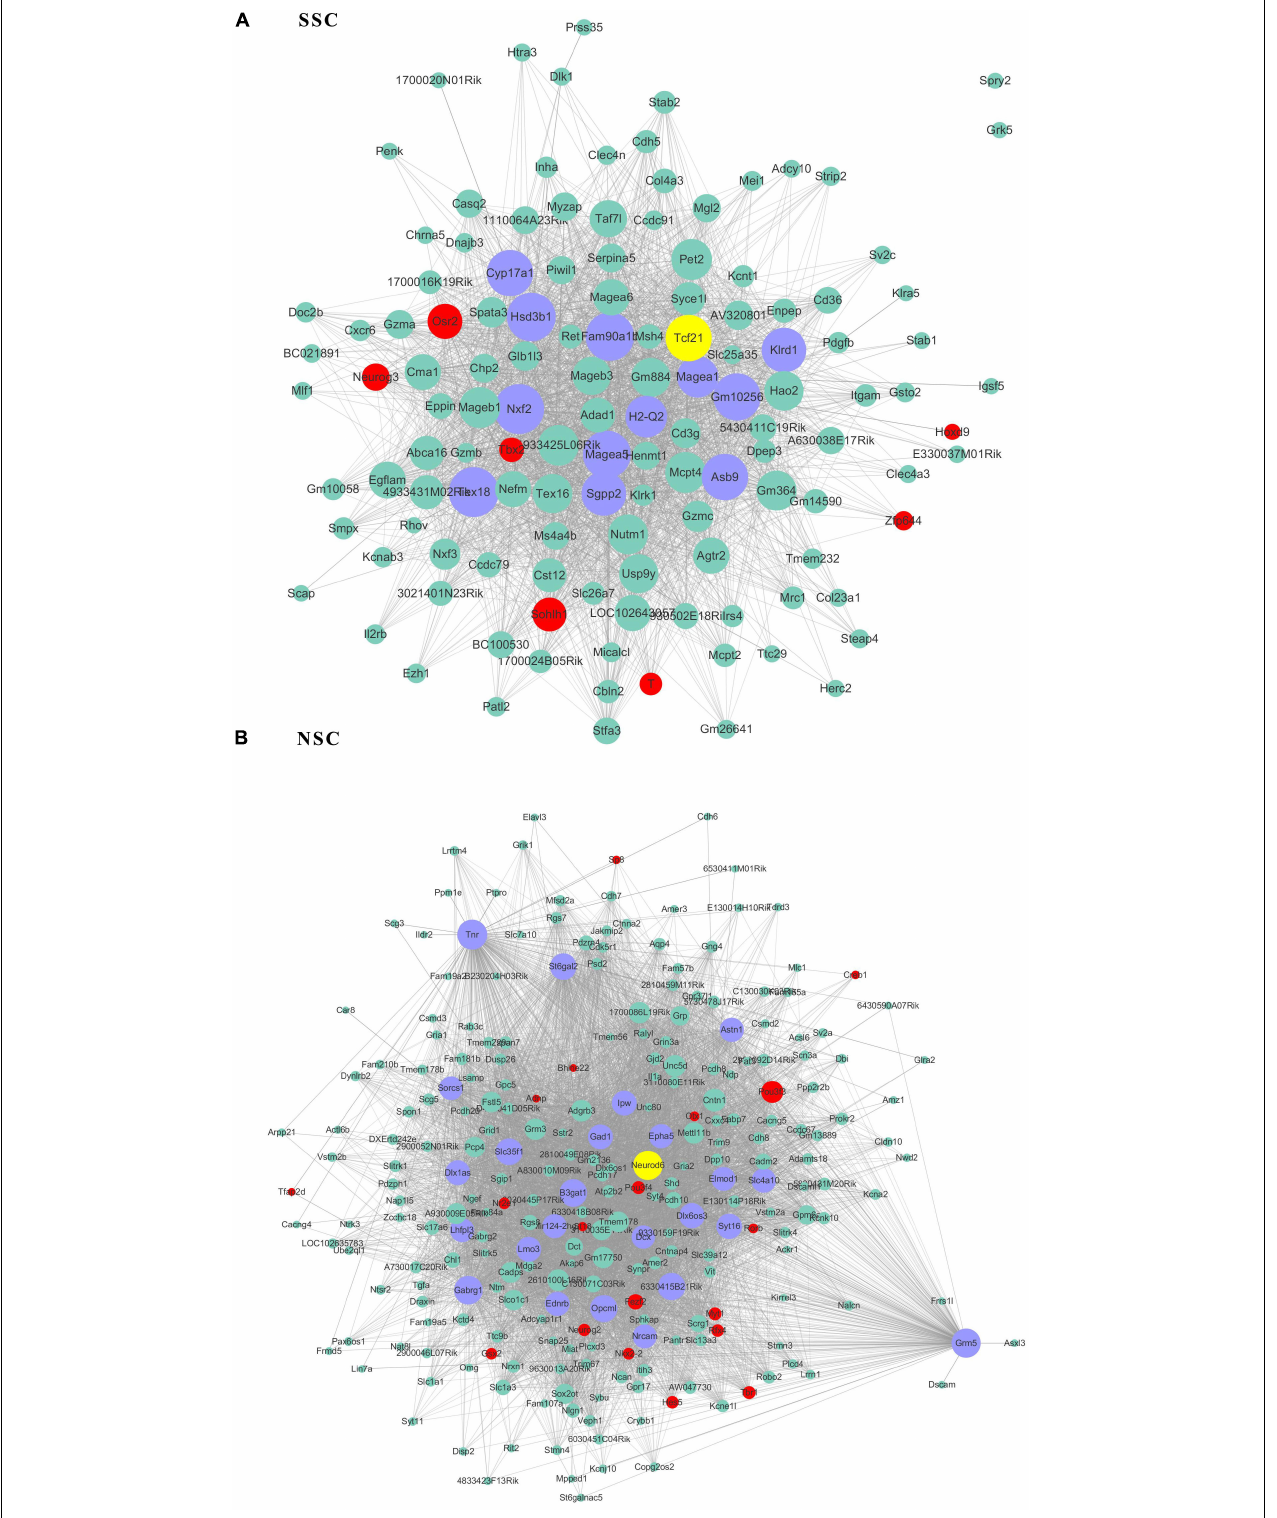
FIGURE 5 | The related co-expression networks of SSC and NSC. SSC-correlated yellow module (A) , NSC-correlated turquoise module (B) . The hub nodes are highlighted in blue within the co-expression networks. Transcription factors within the respective network are highlighted in red. Transcription factors that were included in the top 10% of nodes are highlighted in yellow within the respective networks. The size of the nodes corresponds to their degrees.